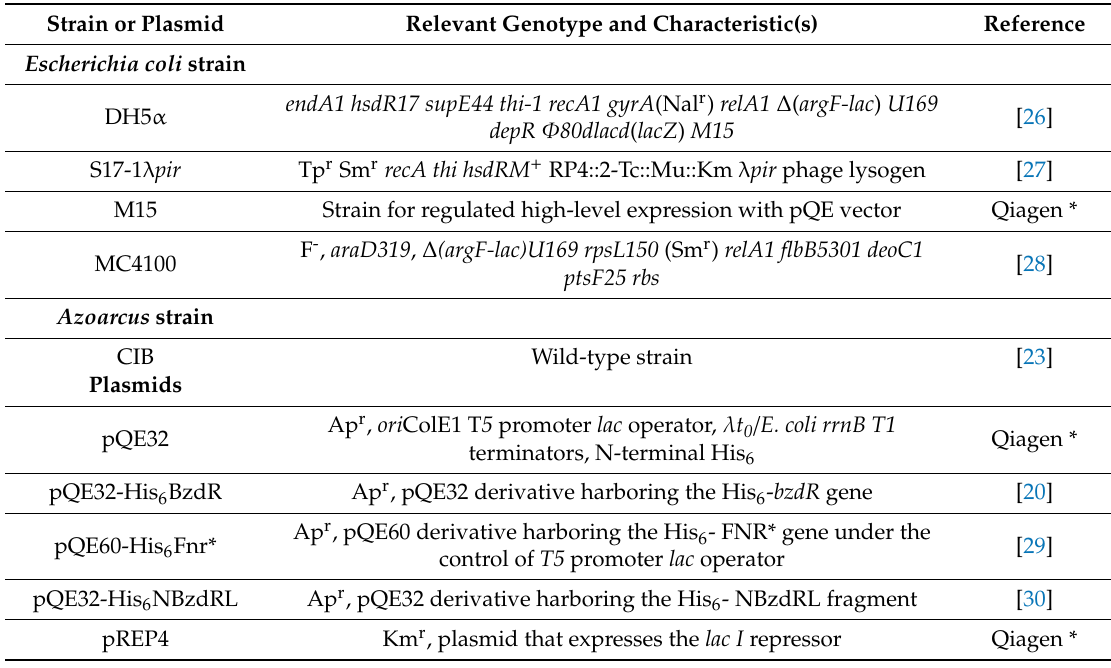
Table 1. Bacterial strains and plasmids used in this